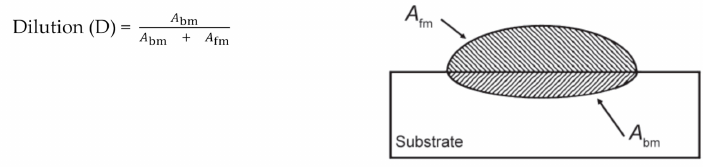
Figure 1. Illustration of dilution of base metal and filler metal in fusion